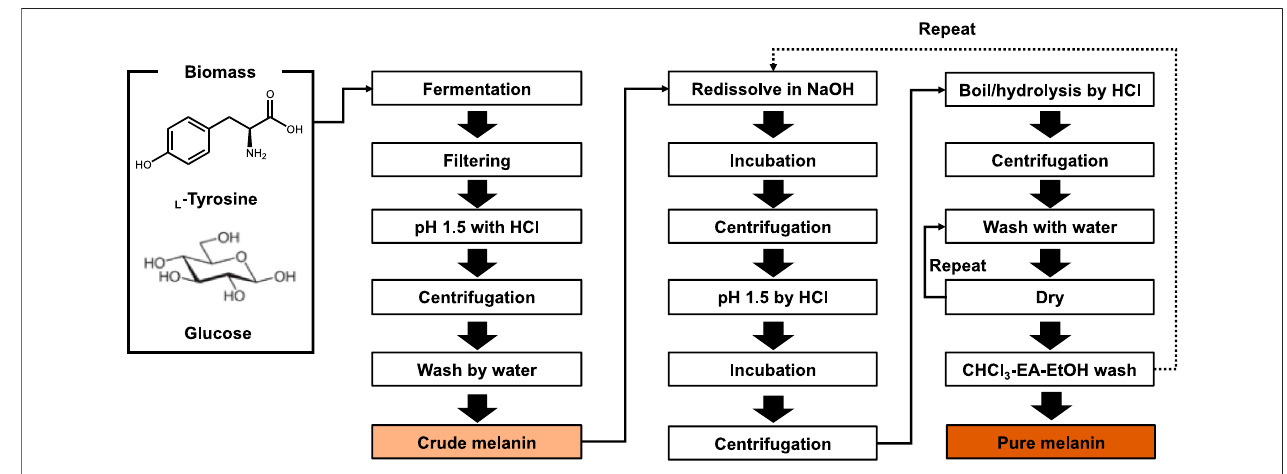
FIGURE 3 | Bioprocess of melanin production and isolation. By several steps of puri fi cation, crude and pure melanin can be obtained.